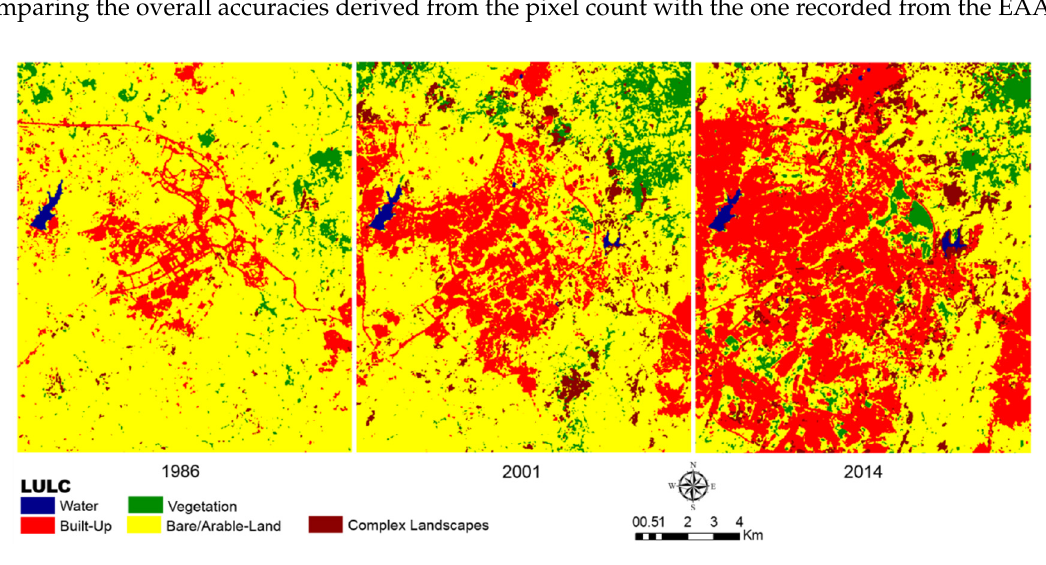
Figure 2. Classified images of Abuja for 1986 ( left ); 2001 ( middle ) and 2014 ( right ). Table 5. Summary of Land Use Land Cover (LULC) map accuracies (%) for 1986, 2001, and 2014 based on the pixel count matrices.